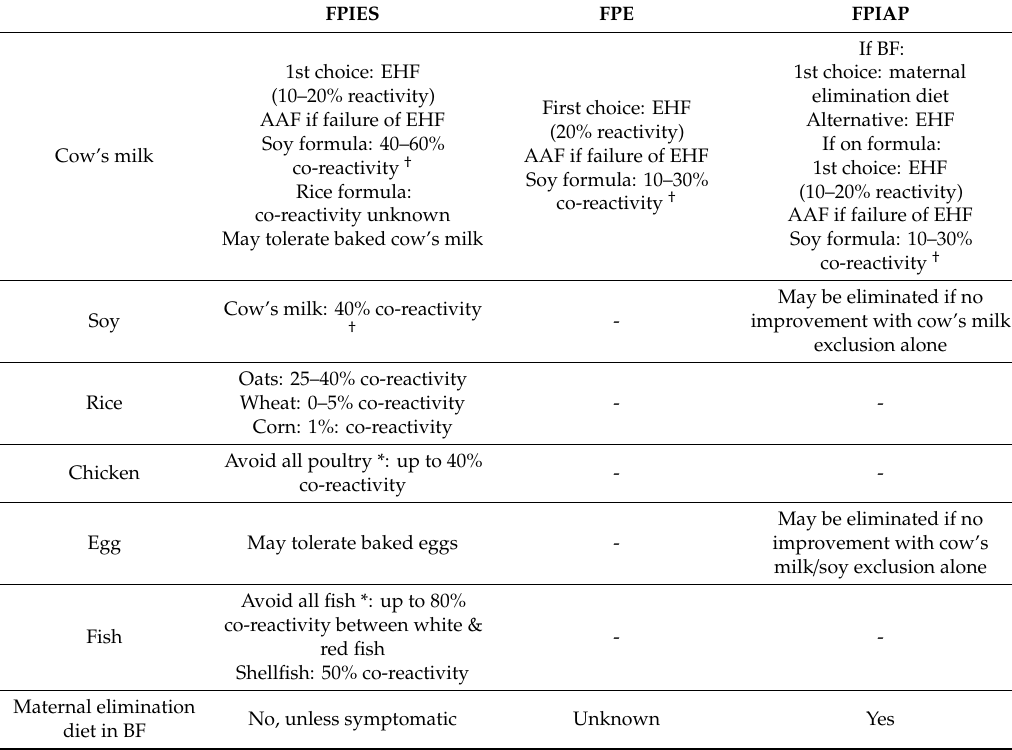
Table 5. Food-specific dietary advice and food co-reactivity in non-IgE-mediated gastrointestinal food